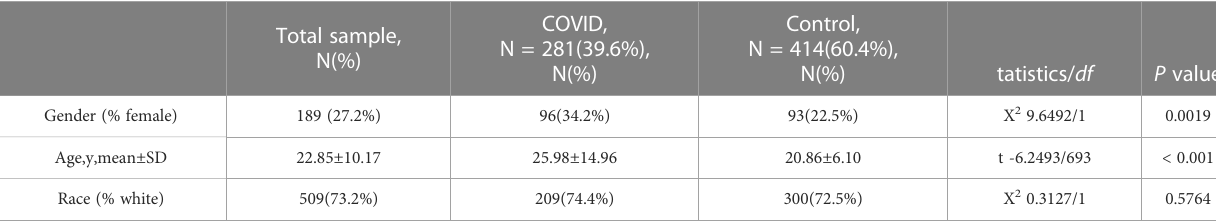
TABLE 2 Clinical characters of samples in the merged COVID training data